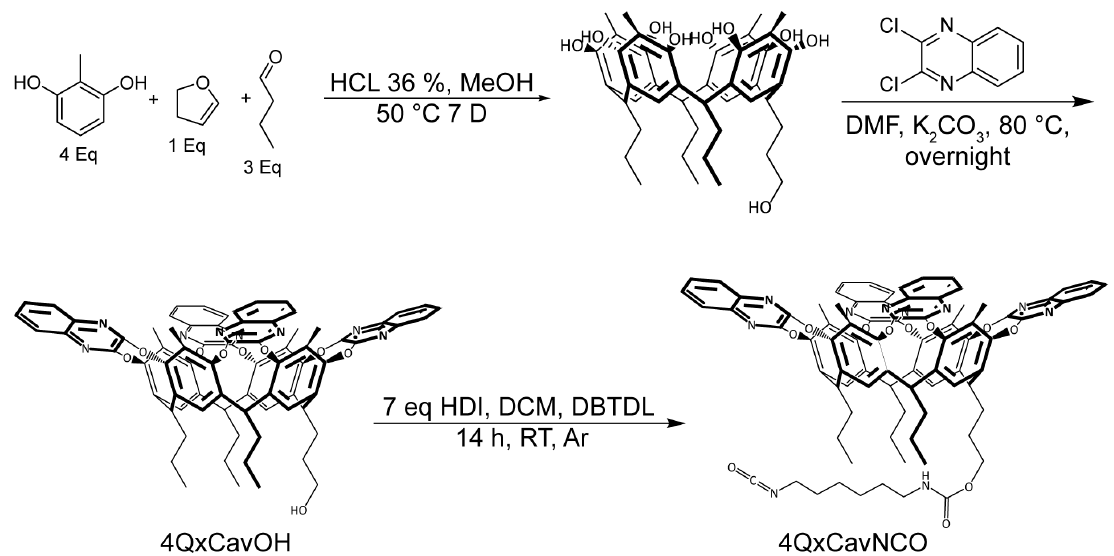
Table 1. Overview of the prepared velcrand functionalized PE, theoretical amount of velcrand introduced in wt%, and thermal